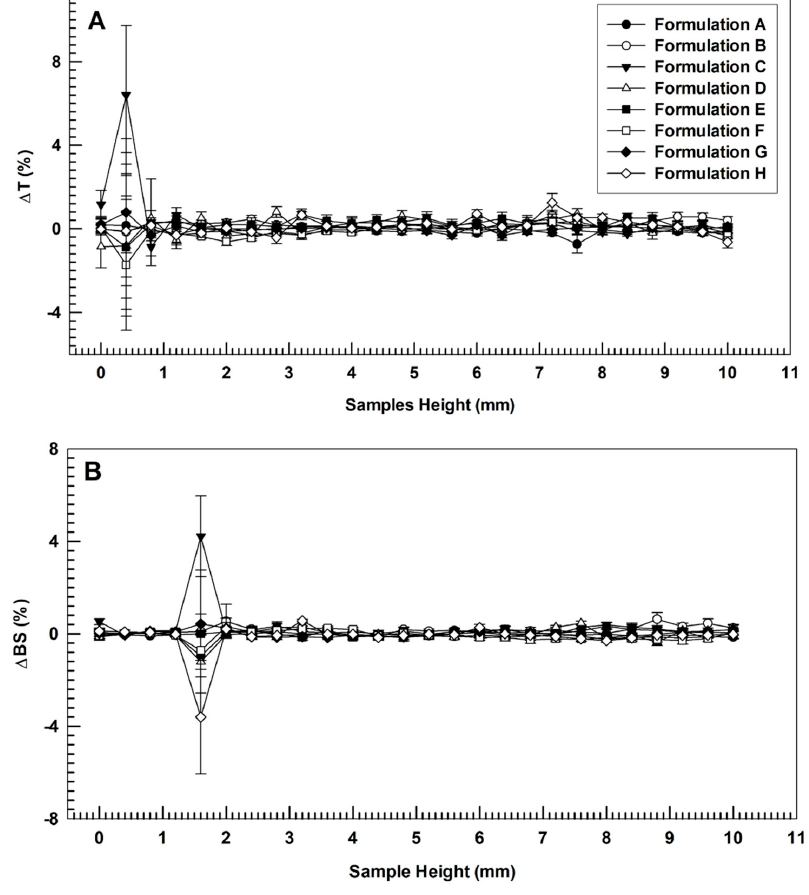
Figure 2. Variation of transmission (Panel ( A )) and backscattering (Panel ( B )) profiles of empty (A),